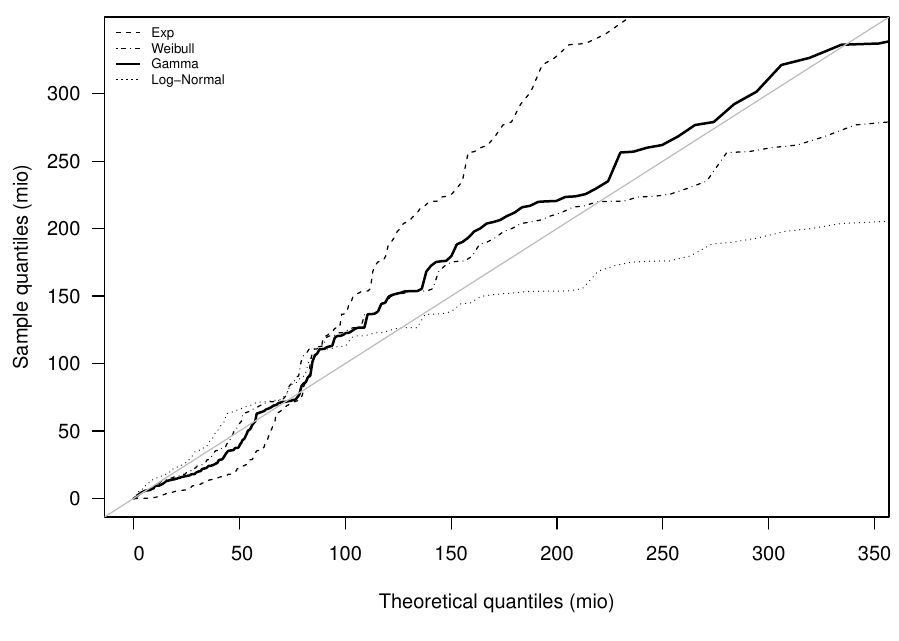
Figure A12. Fit of distribution of the equalization reserves for non-life undertakings.